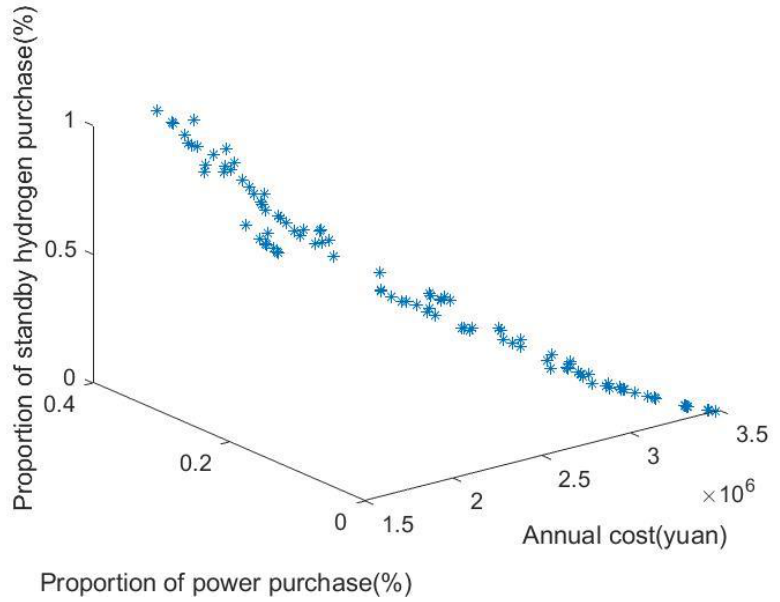
Figure 4. Pareto solution set.